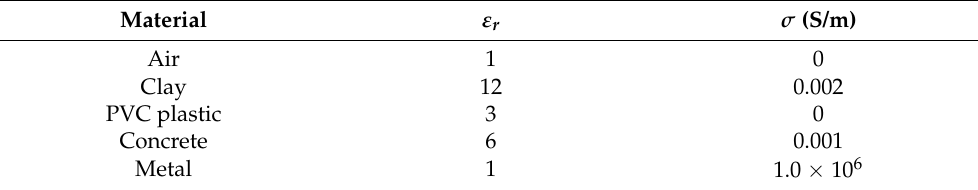
Figure 9. Schematic diagram of model with cavity disease on the lower part of pipeline. Table 2. Conductivity and dielectric constant of different media.